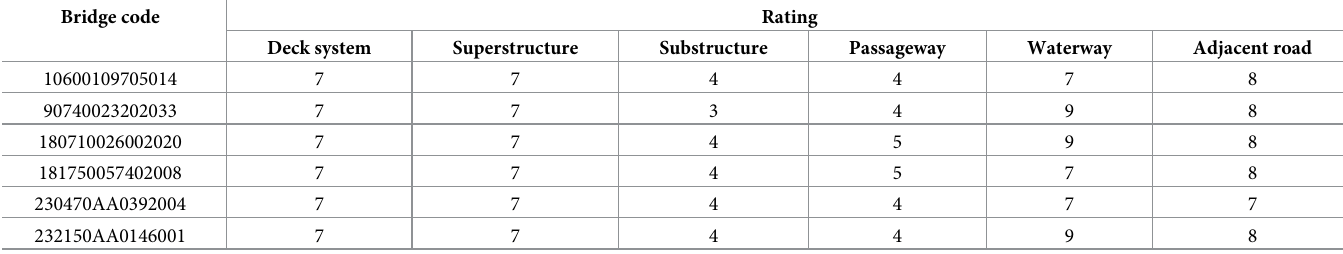
Data source: Screening of statistical